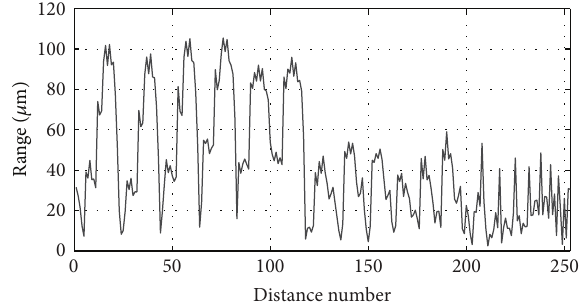
Figure 8: Range of each distance considered in the identification process. Each data represents the difference between the maximum and minimum values of each distance calculated with the measure- ments made by the four